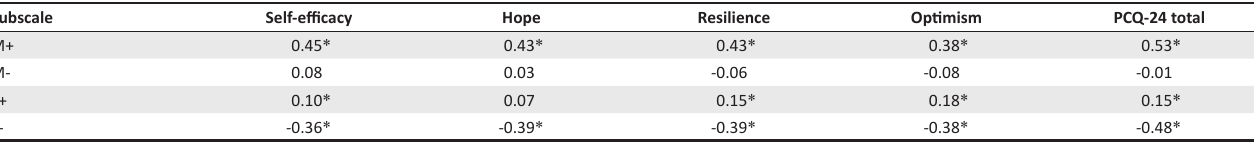
TABLE 3: Correlations between subscales of the EPAQ-R and PCQ-24.